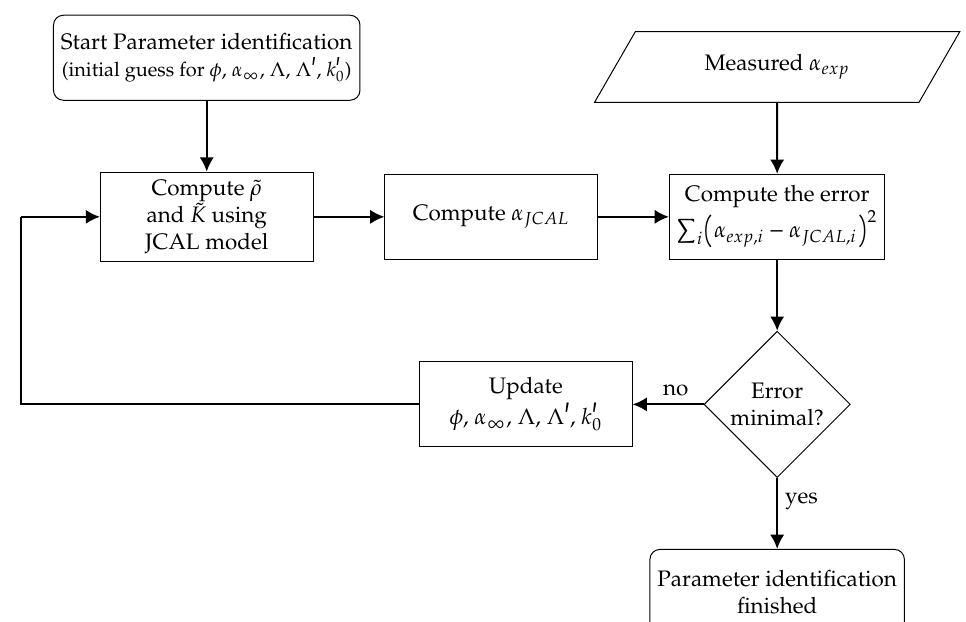
Figure 4. Flowchart of the inverse parameter identification process. Starting with an initial guess for the Biot parameters, the absorption coefficient is computed using the JCAL model and the results is compared to the measured data. Based on the error measure, the Biot parameters are updated until convergence is